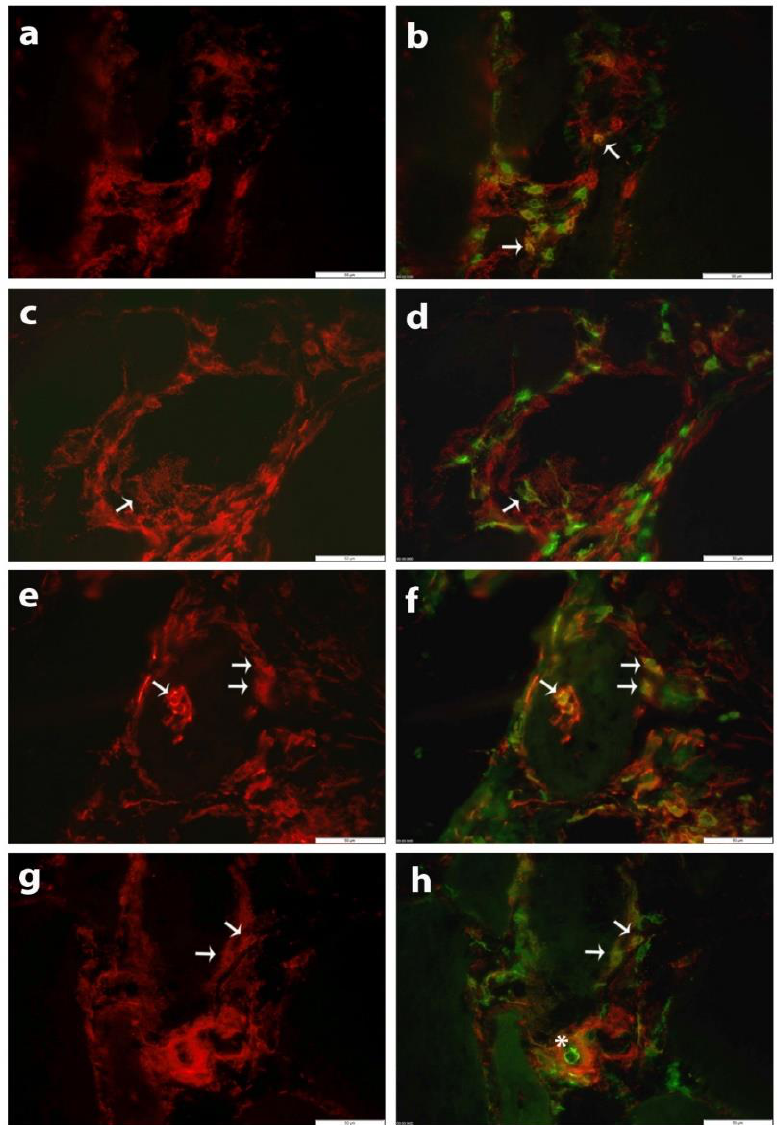
Figure 2. Immunofluorescent staining of SLC5A3 (CY3, red) with antibody Ab2 in skeletal muscle tissue from patient IBM5 ( a – h ). ( b ) Double stain with anti-CD3 (AlexaFluor488, green) shows partial co-localization (arrows). ( d ) Double stain with anti-CD206 (AlexaFluor488, green) marks a cell that is weakly SLC5A3 positive (arrow). ( f ) Double staining with anti-CD68 (AlexaFluor488, green) shows part of these cells are strongly positive, mostly cells invading and surrounding a non-necrotic fiber (arrows). ( h ) A CD68 + cell (AlexaFluor488, green) adherent to the luminal side of a blood vessel is negative (asterisk), while subsets of endomysial CD68 + cells express SLC5A3 (arrows). Scale bars 50 µ m in all panels.